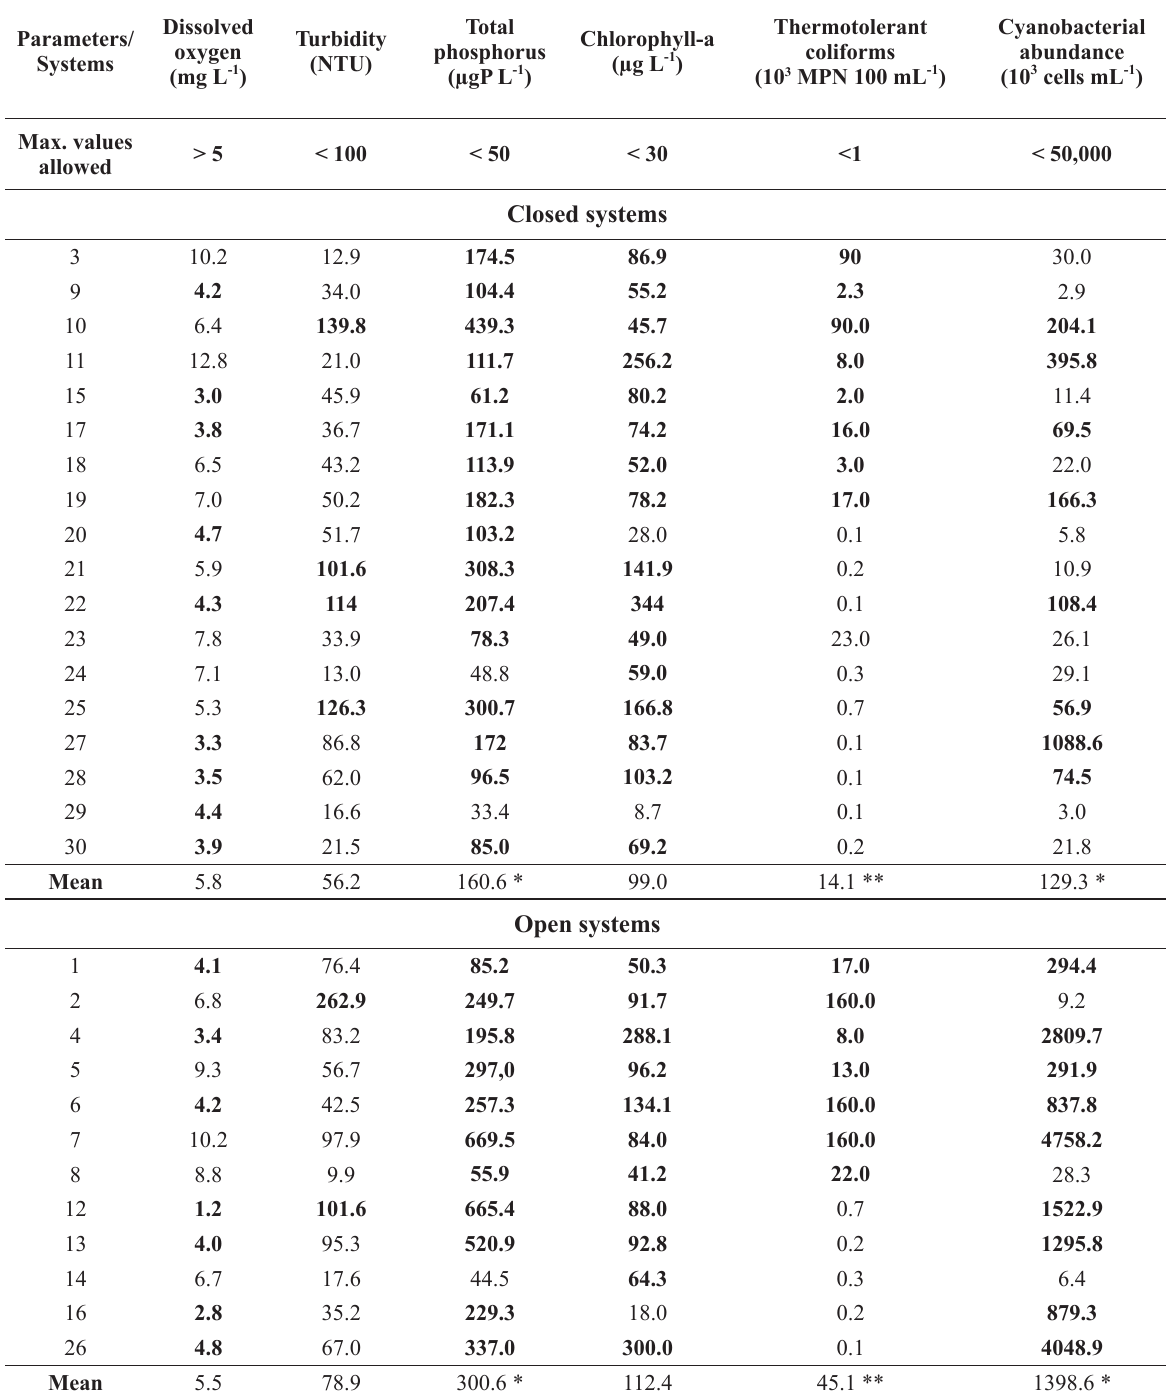
Established parameters for Class II water quality, indicated by Brazilian legislation (CONAMA 357/2005) for aquaculture and fishing activities, and results for 30 fishponds in the state of Rio de Janeiro.(MPN = most probable number). In bold, parameters exceeding the mandated limits. * p<0.05; ** p<0.1;